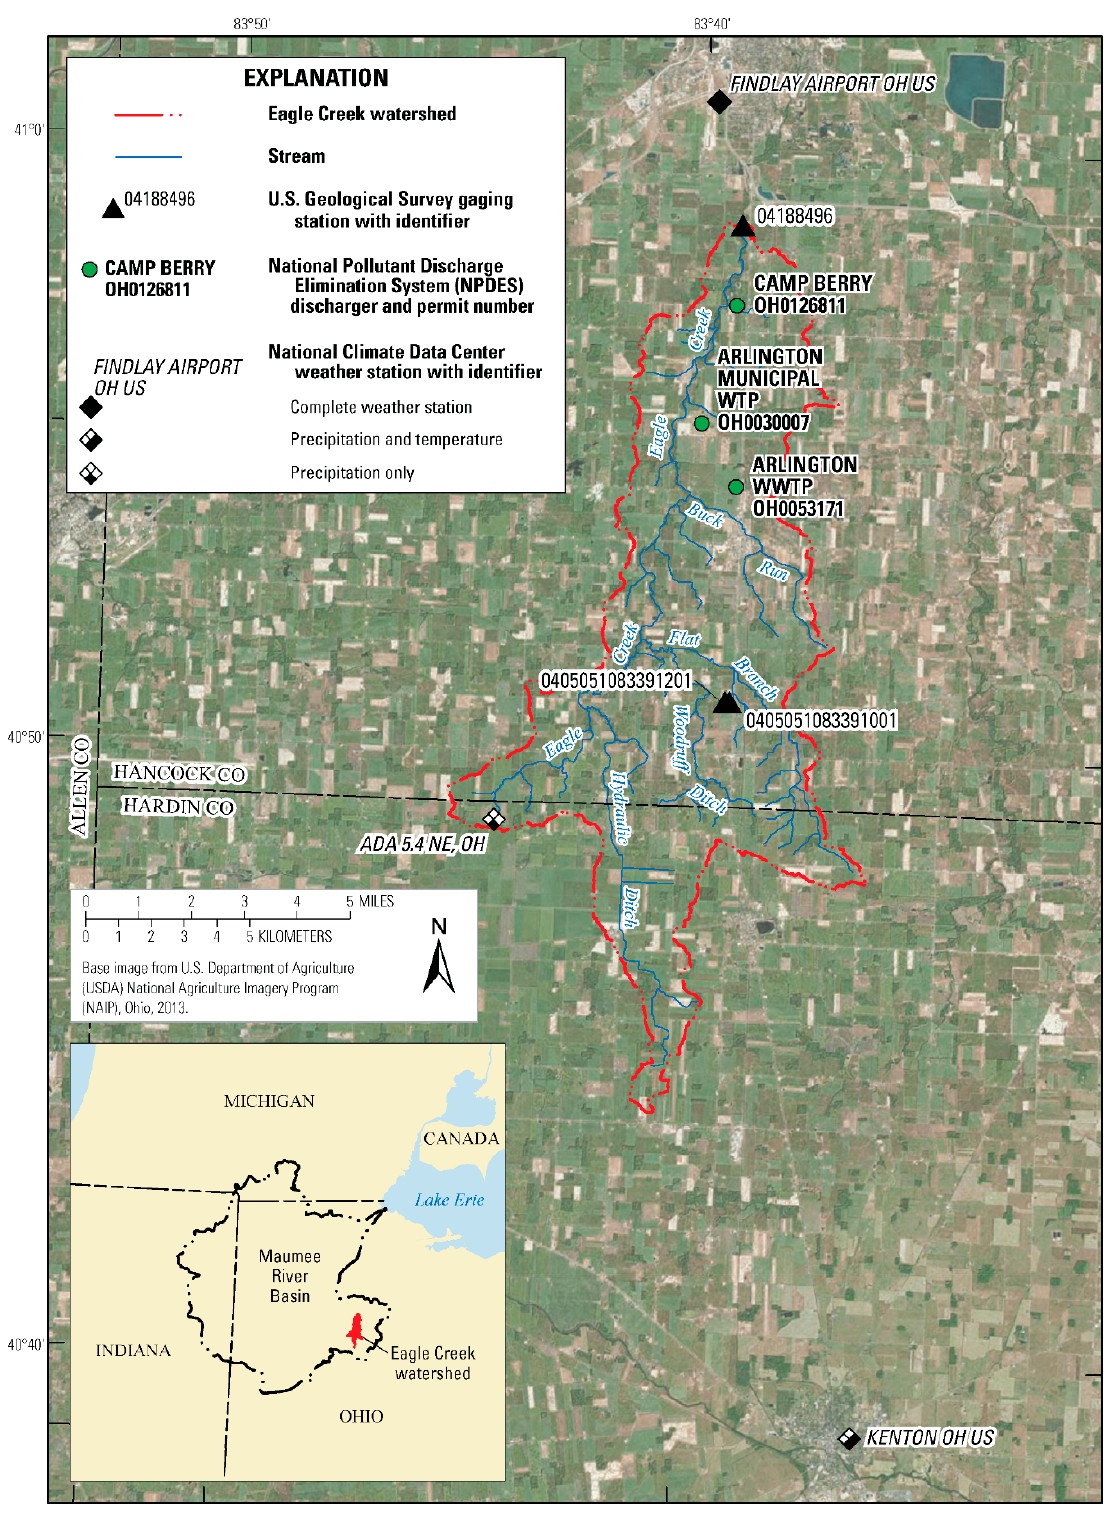
Figure 1. Locations of U.S. Geological Survey (USGS) gaging stations, National Climatic Data Center (NCDC) weather stations, and National Pollutant Discharge Elimination System (NPDES) sites in the Eagle Creek watershed, Ohio.